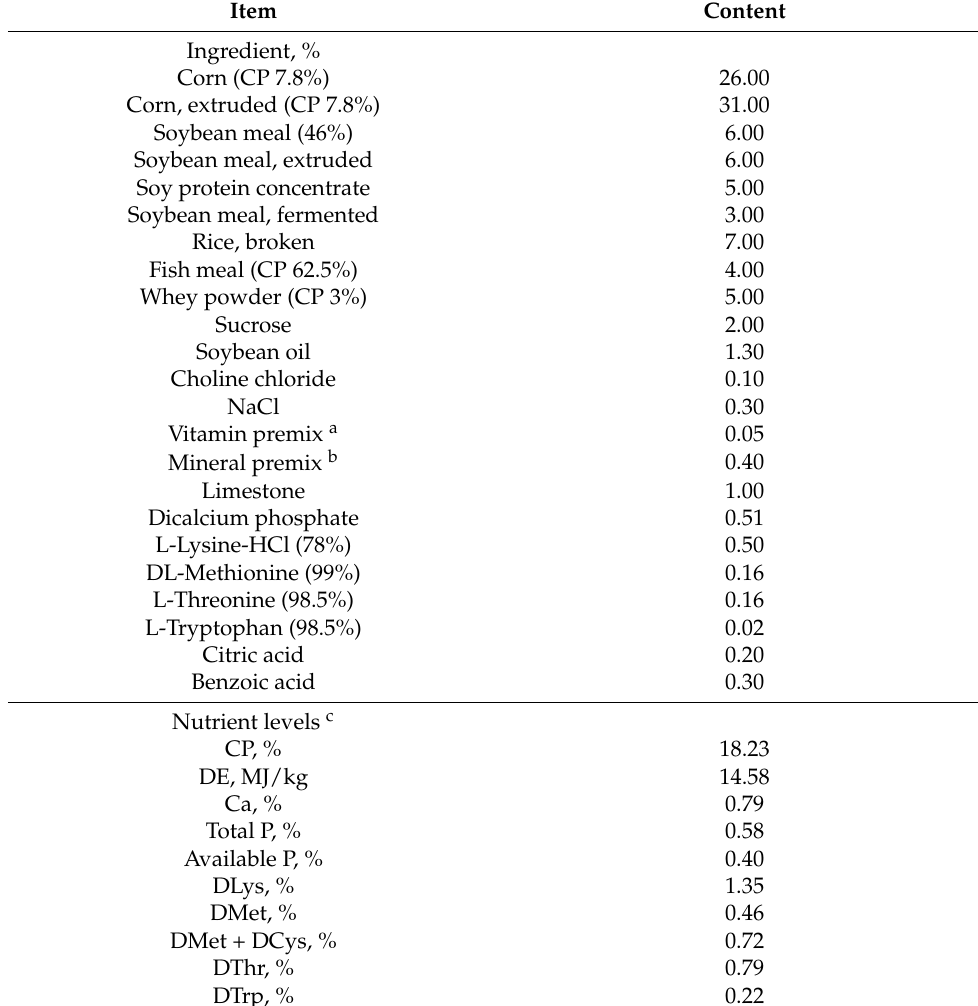
Table 1. Ingredients and nutrient composition of the experimental diets (as-fed